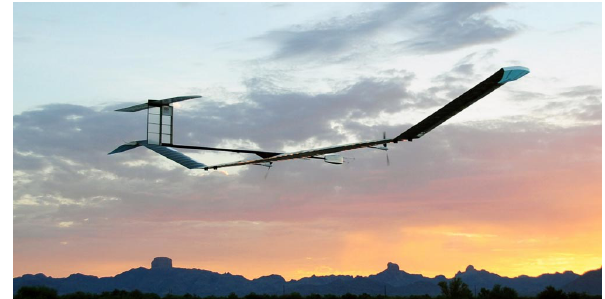
Figure 2. Airbus Zephyr during flight